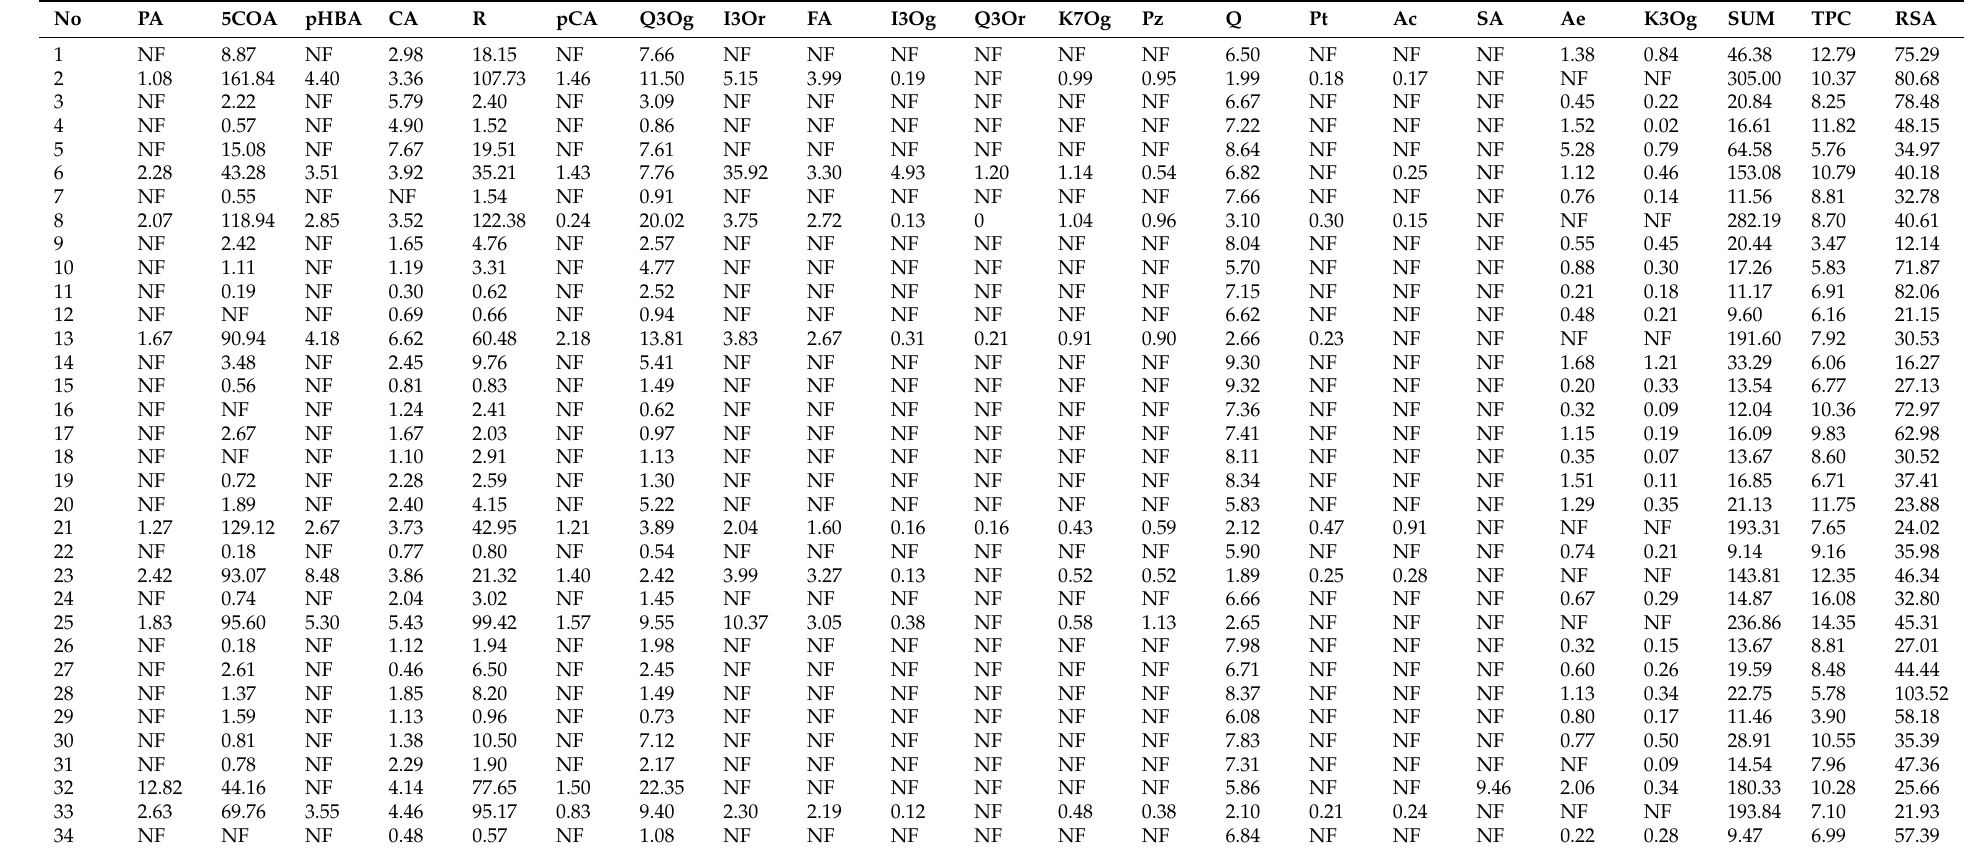
Table A4. Content of phenolic compounds (mg/kg), total phenolic content (TPC, g GAE/kg dw), and relative scavenging activity (RSA, mmol TE/kg dw) in 68 Norwegian plum cultivars from Njøs (42 samples) and NIBIO Ullensvang (8 samples) collected in 2019 and 2021, and from NMBU (18 samples) collected in 2019 and